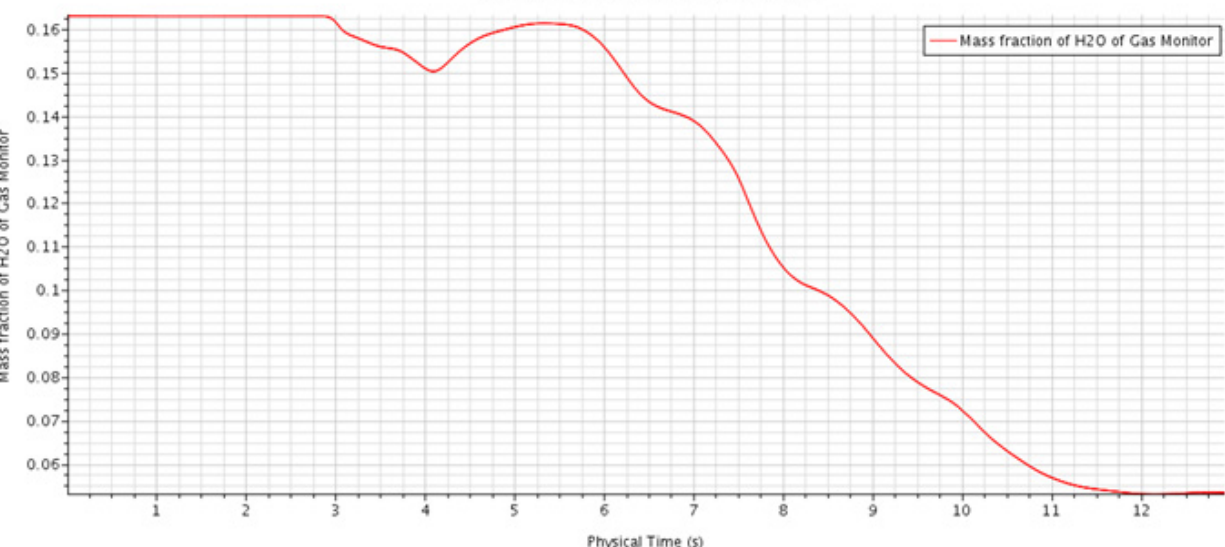
Figure 10. Mass fraction of water vapour.